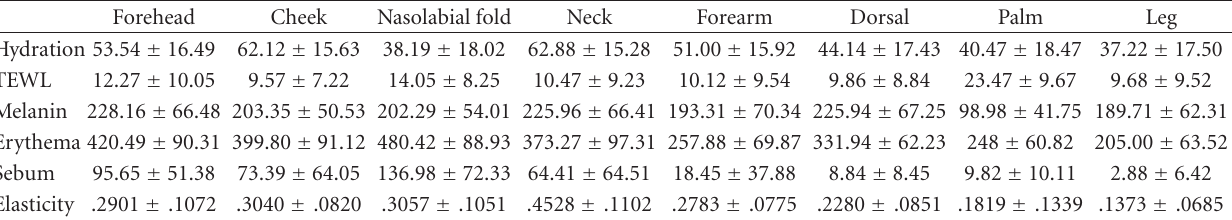
Table 3: The mean and standard deviation of skin hydration, TEWL, melanin index, erythema index, sebum, and elasticity according to body